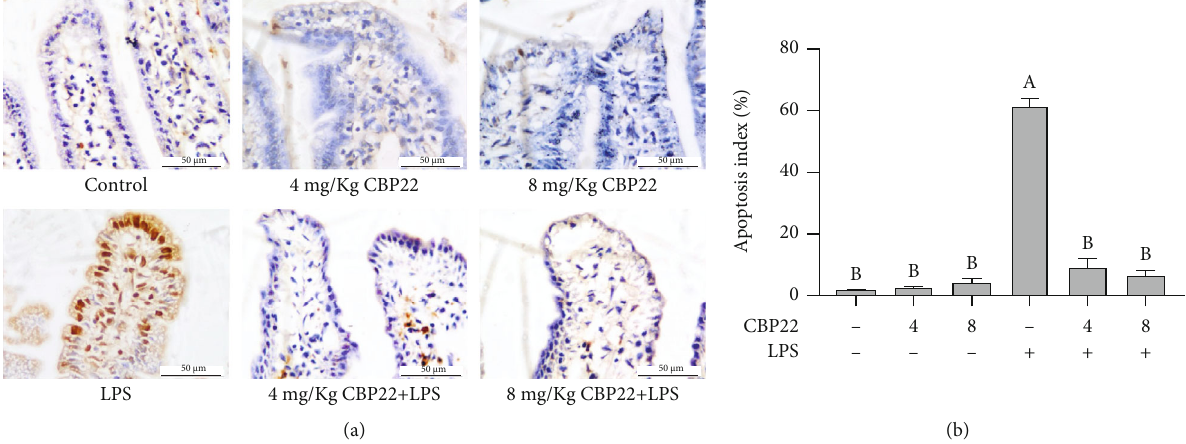
Figure 4: The e ff ect of CBP22 on jejunum cell apoptosis in mice. (a) TUNEL staining of jejunal epithelial tissues, brown signals, scalebar = 50 μ m . (b) Apoptosis index of jejunal epithelial cells. The data are expressed as the mean ± SEM , n = 10 biological replicates; bars with di ff erent small capital letters are statistically di ff erent from one another.